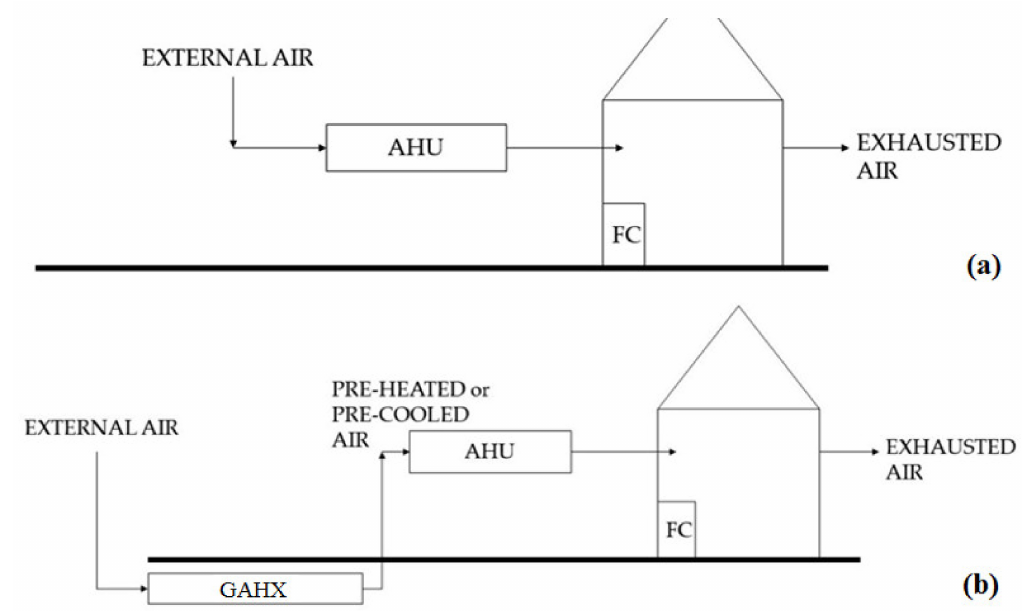
Figure 5. ( a ) HVAC system without GAHX. ( b ) HVAC system with GAHX.